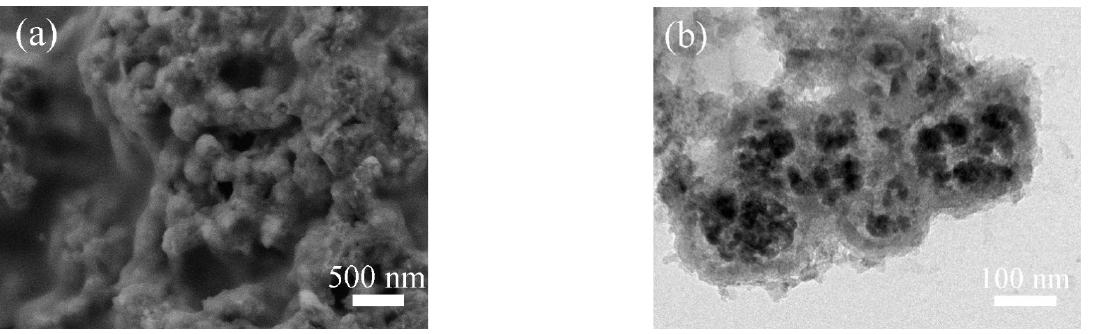
Figure 8. ( a ) SEM and ( b ) TEM images of MnS@CoS/C@C after 300 cycles at 5 A g − 1 .